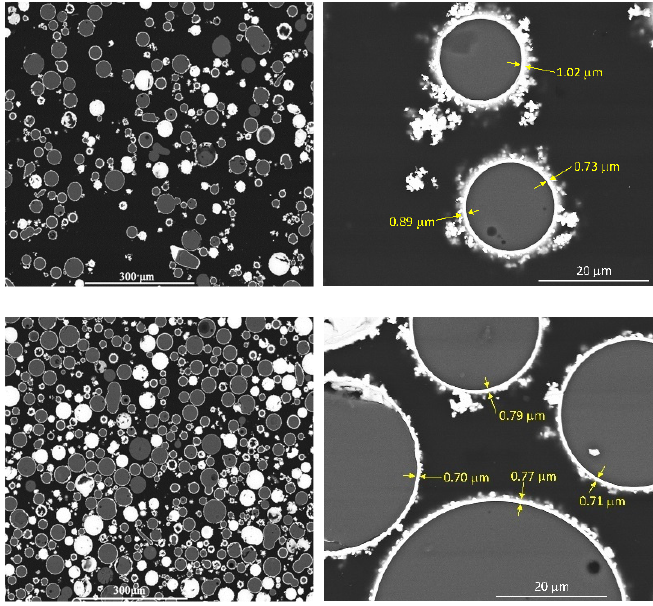
Figure 5. SEM micrographs with different magnification for the composite of 31% volume content (top) and 45% (bottom) of silver-coated glass beads dispersed in the epoxy matrix.